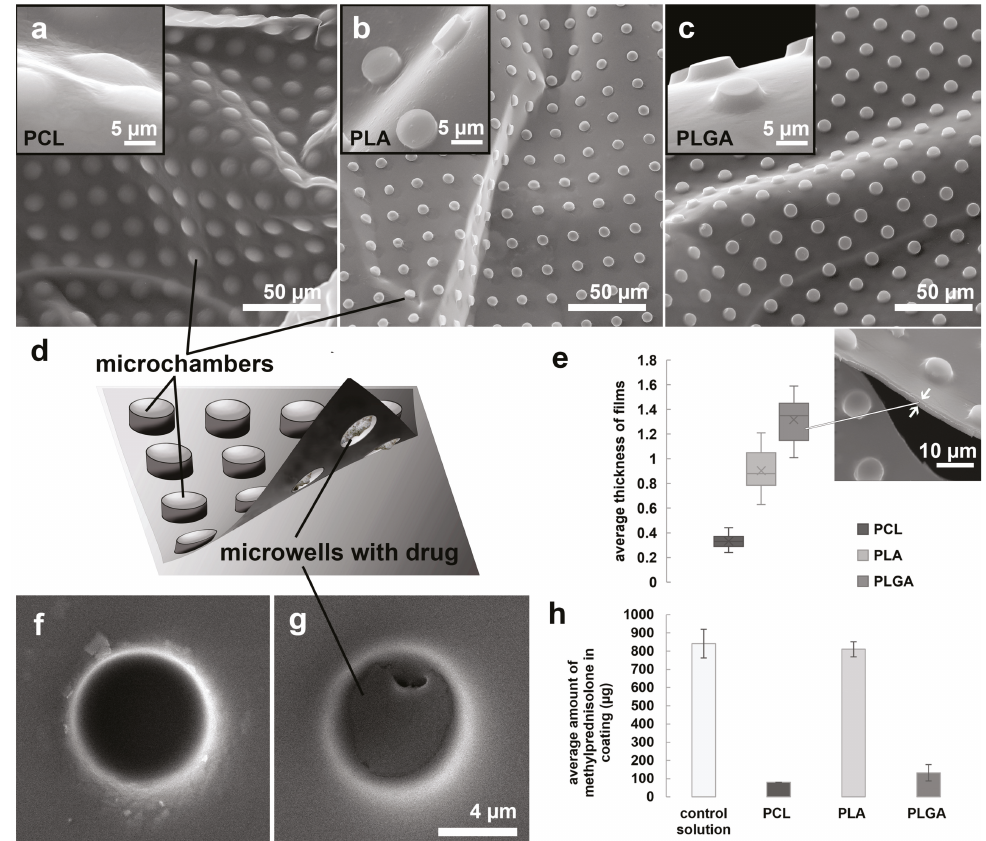
Figure 2. SEM images of the outer surface of microchamber arrays based on PCL ( a ), PLA ( b ), and PLGA ( c ). General scheme of microchamber array structure ( d ). The average thickness of microcham- ber array films based on PCL, PLA, PLGA ( e ). The inner surface of the empty ( f ) and filled with methylprednisolone sodium succinate ( g ) microwells. The average amount of methylprednisolone measured with GC-MS in the stent coating based on PCL, PLA, and PLGA ( h ).